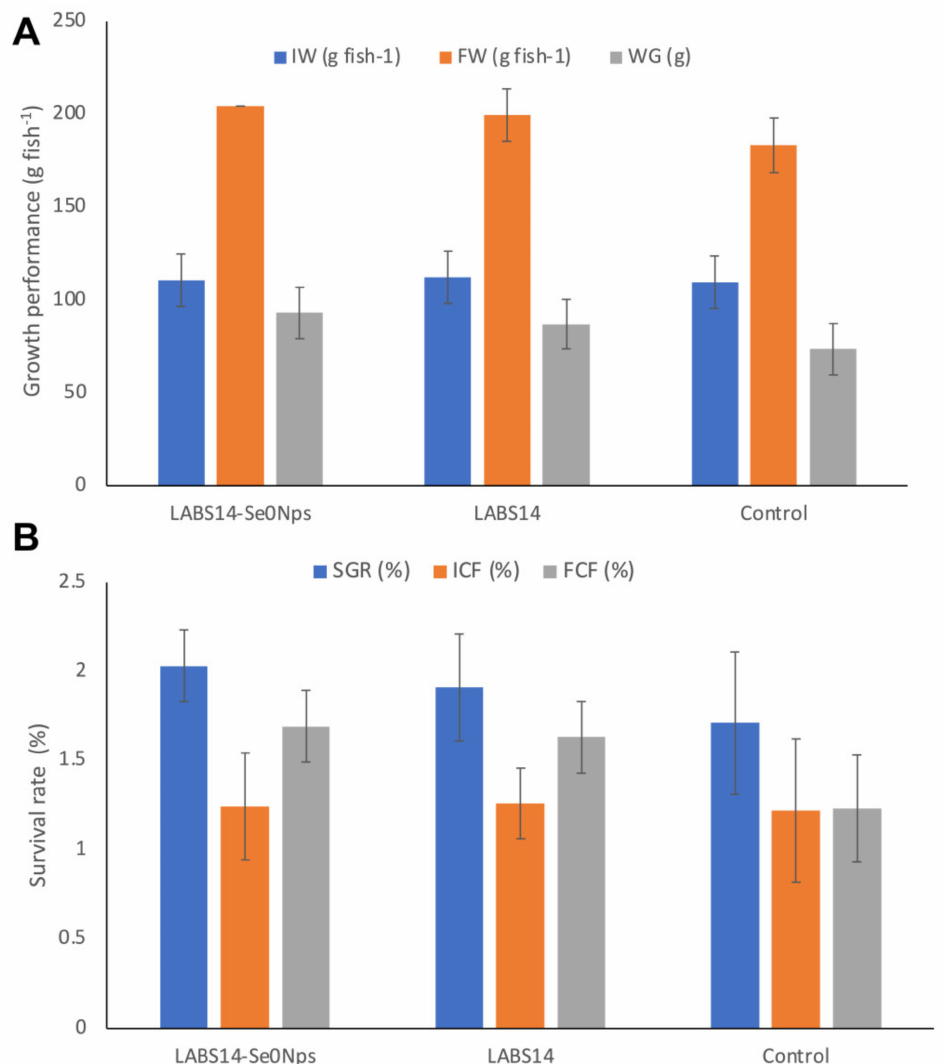
Figure 6. Growth performance. ( A ) initial weight (IW), final weight (FW) and weight gain (WG). ( B ) specific growth rate (SGR), initial condition factor (ICF) and final condition factor (FCF) of rainbow trout whose food was supplemented, for 30 days, with 10 8 CFU of Se nanoparticle-enriched Lactiplantibacillus plantarum S14 strain (LABS14-Se 0 Nps) g − 1 or 10 8 CFU L. plantarum S14 strain (LABS14) g − 1 . Control did not receive the bacterial strain. Bars indicate standard